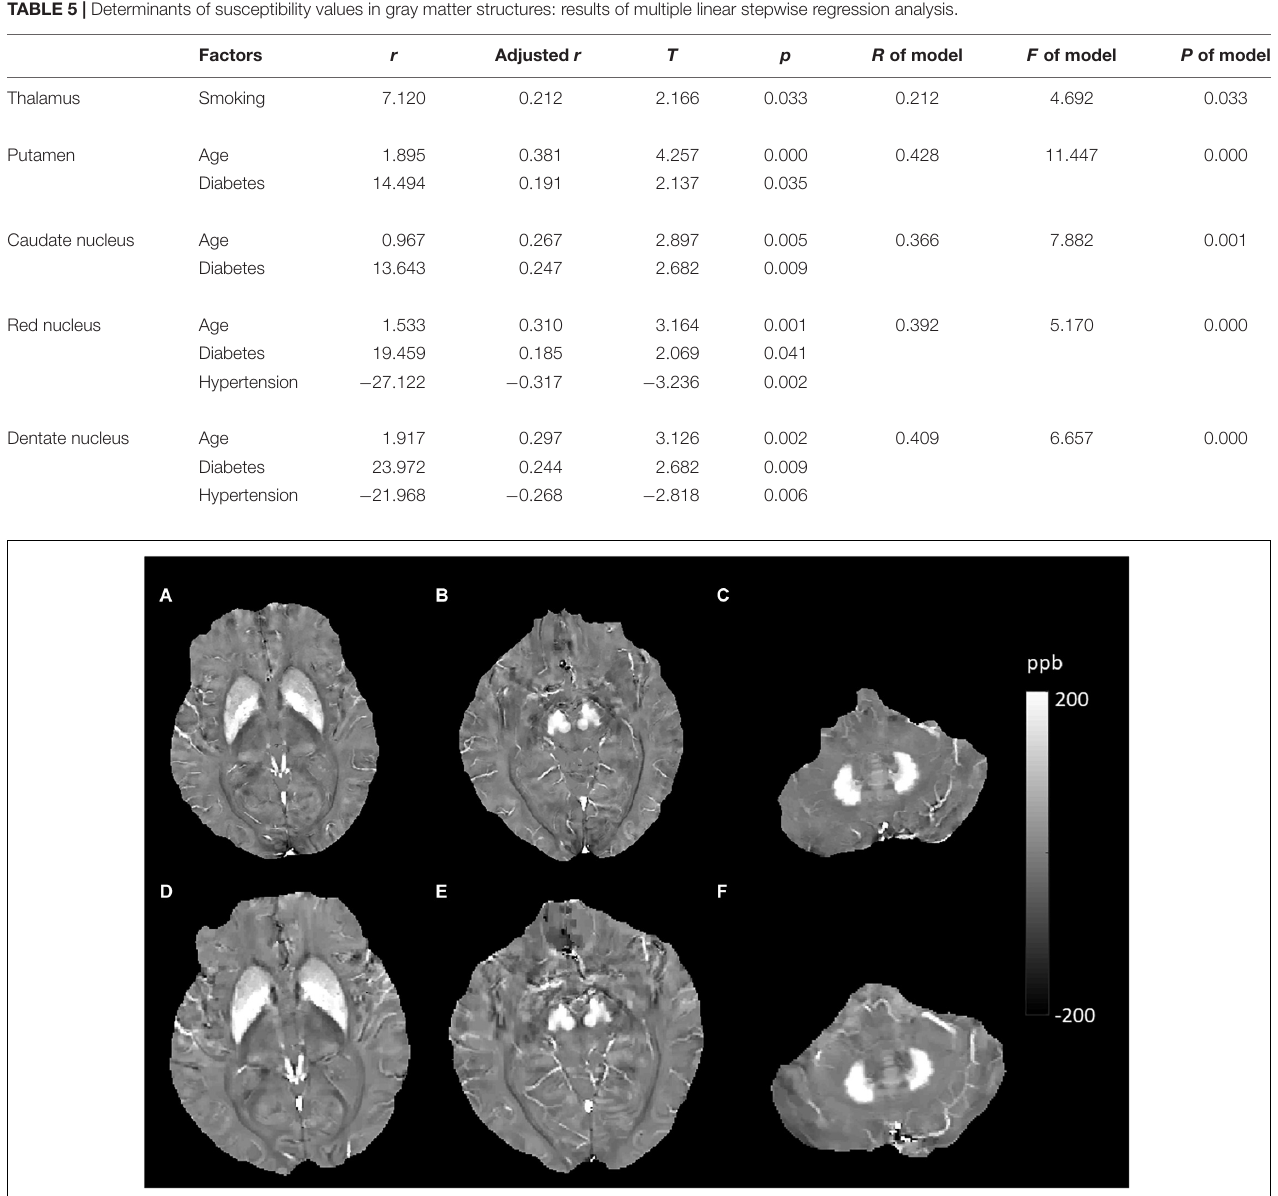
FIGURE 4 | Evolution of susceptibility values with age in the caudate nucleus, putamen, globus pallidus, red nucleus, substantia nigra, and dentate nucleus. These images were from an 80-year-old male non-smoker without hypertension and type 2 diabetes mellitus (T2DM). The upper row (A–C) shows quantitative susceptibility mapping (QSM) images acquired in 2010, and the bottom row (D–F) shows QSM images acquired in 2019. Susceptibility values of the gray matter nuclei increased significantly over